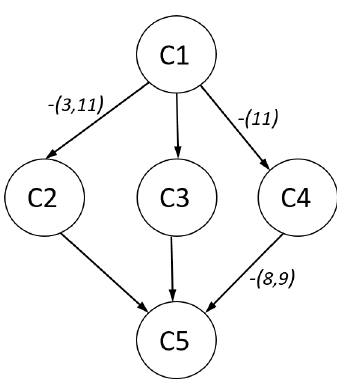
Figure 4. SPM-LS dichotomous data: partial order for latent class from RLCM. Table 12. SPM-LS polytomous data: estimated item response probabilities and latent class probabilities